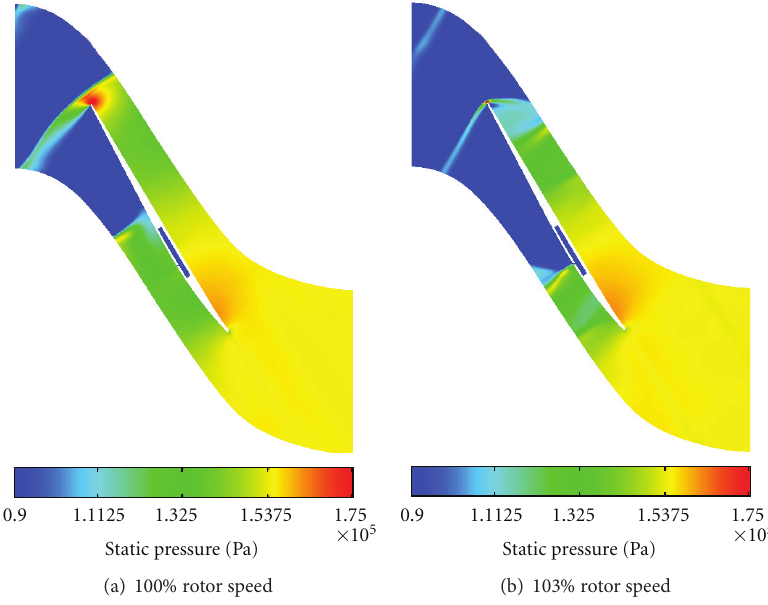
F 7: Static pressure contours at midspan of rotor two. Adiabatic three harmonic